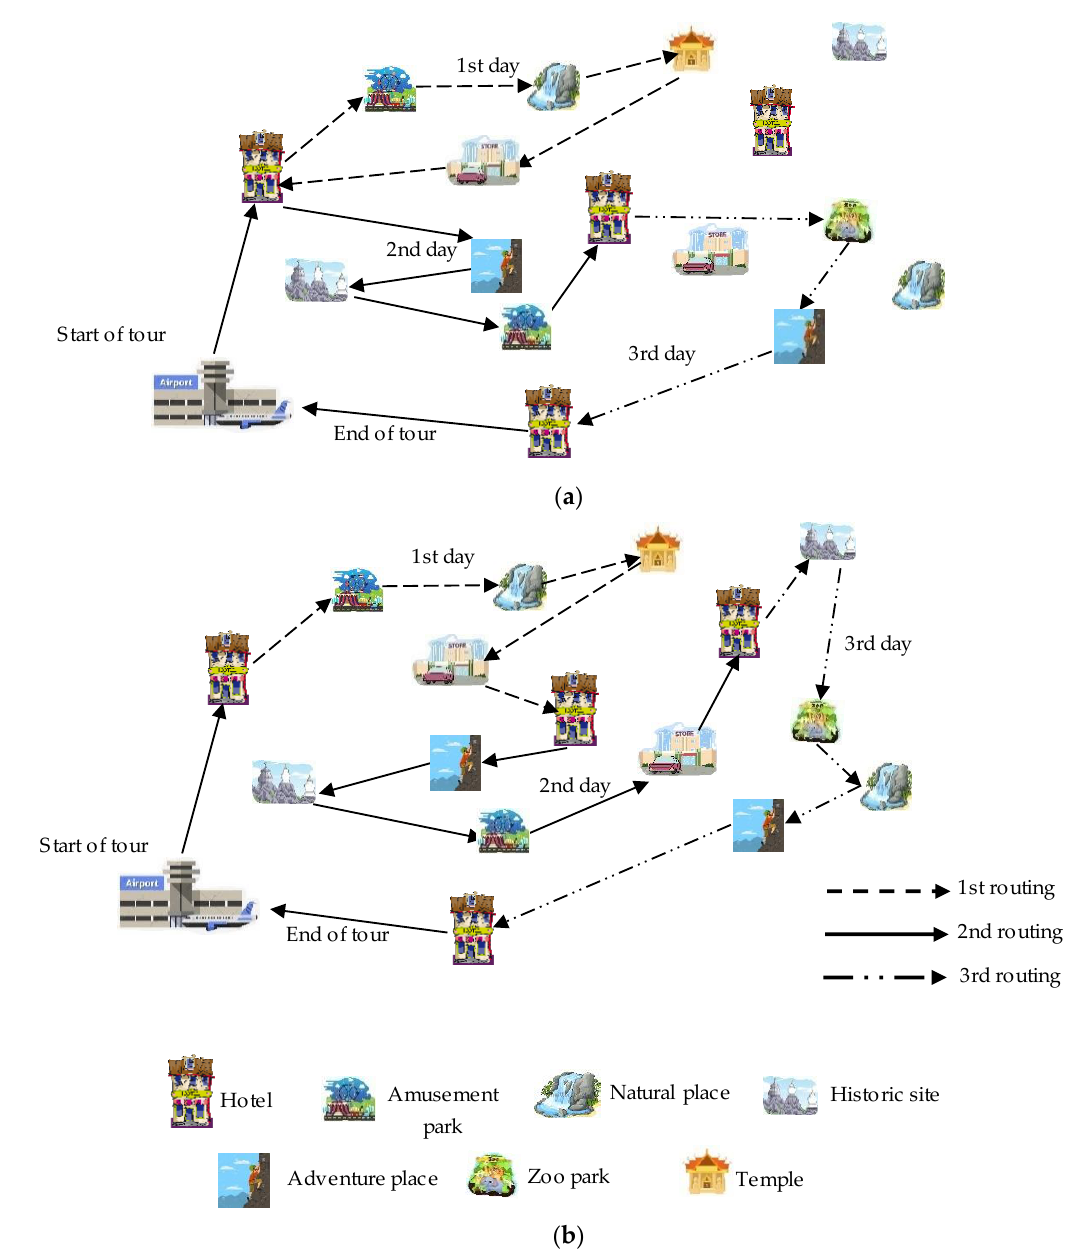
Figure 1. Family tourism problem framework ( a ) Problem pattern of family tourism routing. and ( b ) Problem pattern solving.